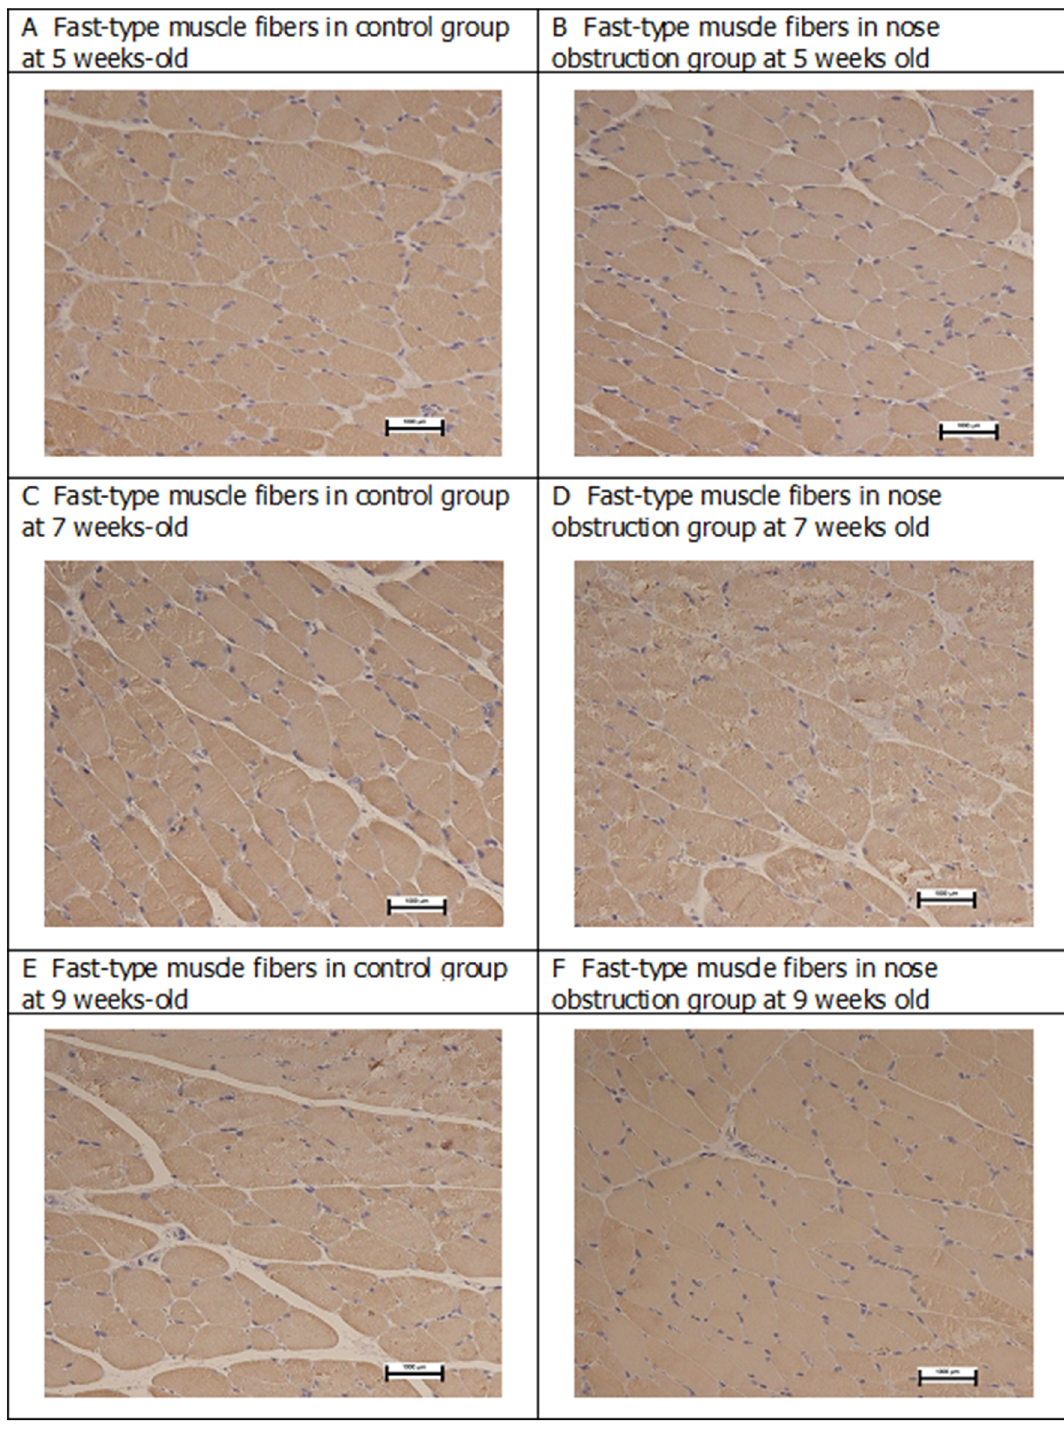
Figure 5. Representative images of the genioglossus fast-type muscle fibers in the 5-, 7-, and 9-week-old rats. Figures at ×20 magnitude. 1000 μm scale bar. MHC-fast Myosin heavy chain expression of fast-type muscle